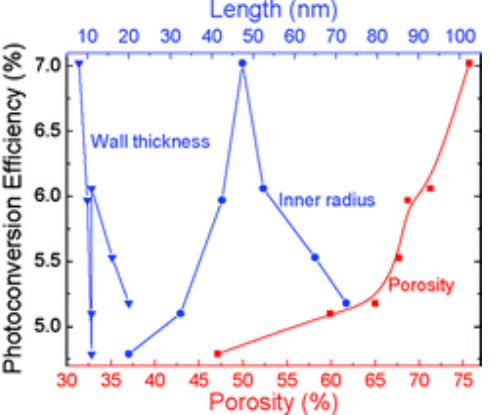
Figure 9. Experimental effect of the porosity (determined by the wall thickness and diameter) on the photoconversion efficiency of water-splitting cells. Reprinted with permission from [63]. Copyright 2012 American Chemical Society.